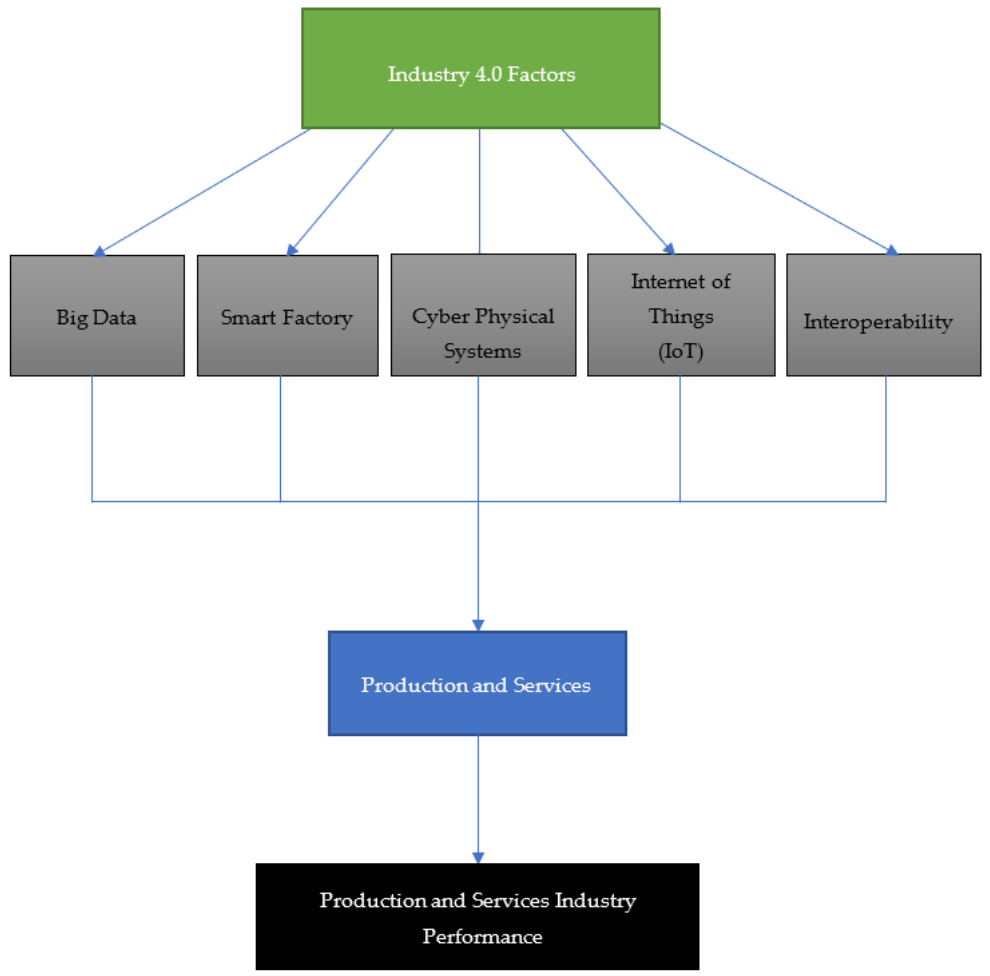
Figure 2. Influence of Industry 4.0 factors on production, services, and company performance. Source: Developed by the current study.